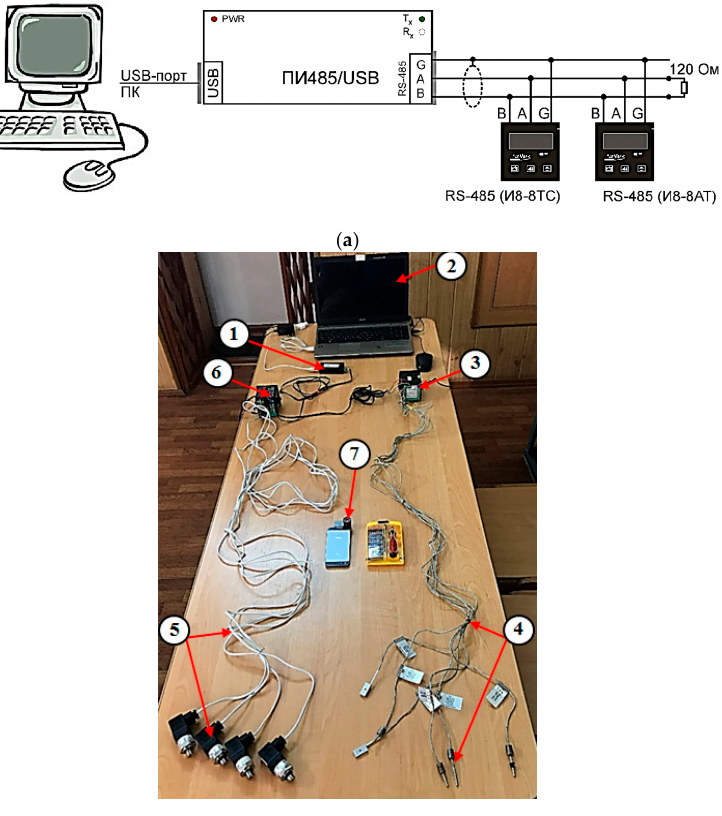
Figure 5. The measurement system and control of the experimental setup parameters: ( a ) connection scheme of the PI485/USB communication interface with a PC and eight-channel meters; ( b ) infor- mation and measurement system: 1—PY485/USB communication interface; 2—PC with installed software; 3—eight-channel temperature meter; 4—temperature sensors; 5—pressure sensors; 6— eight-channel pressure meter; 7—thermal imager.